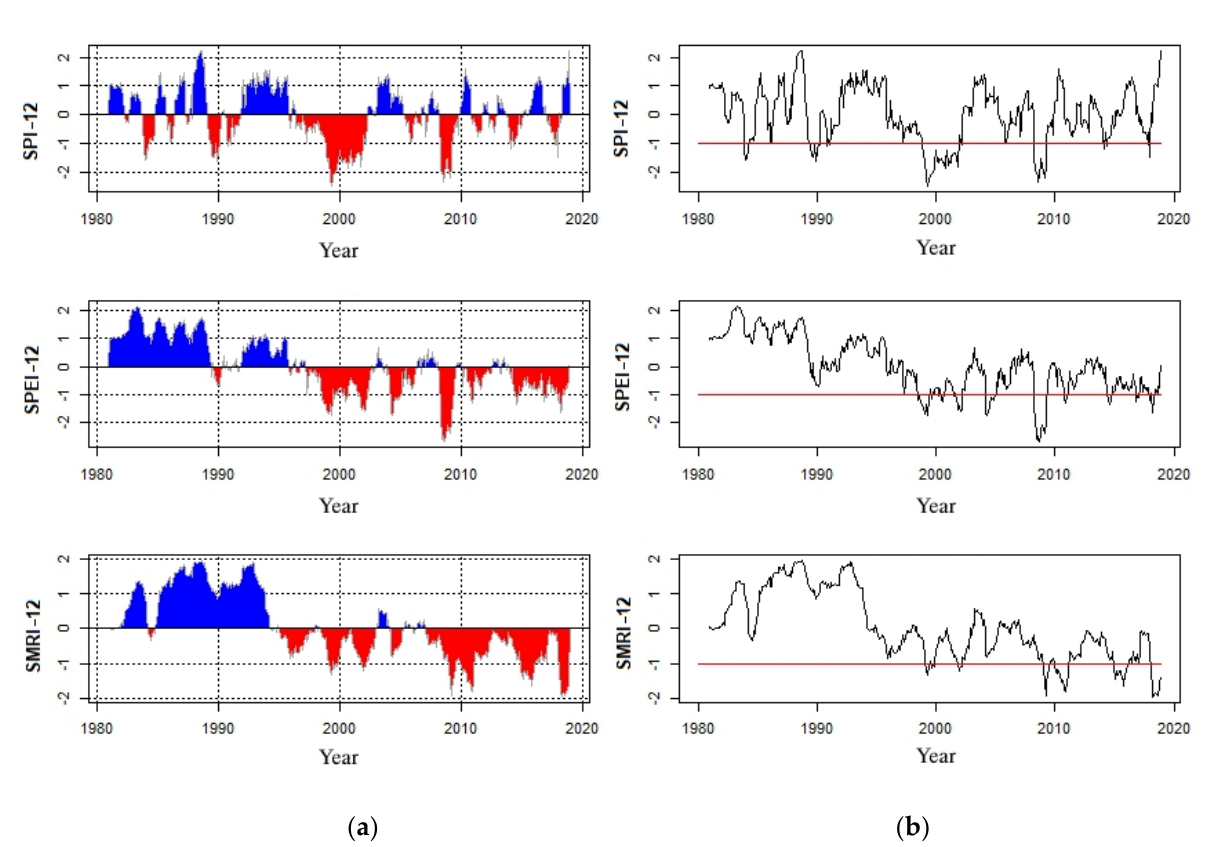
Figure 8. Time series of SPI, SPEI and SMRI indices of ULB over 1981–2018 ( a ) and their values under the threshold of − 1 ( b